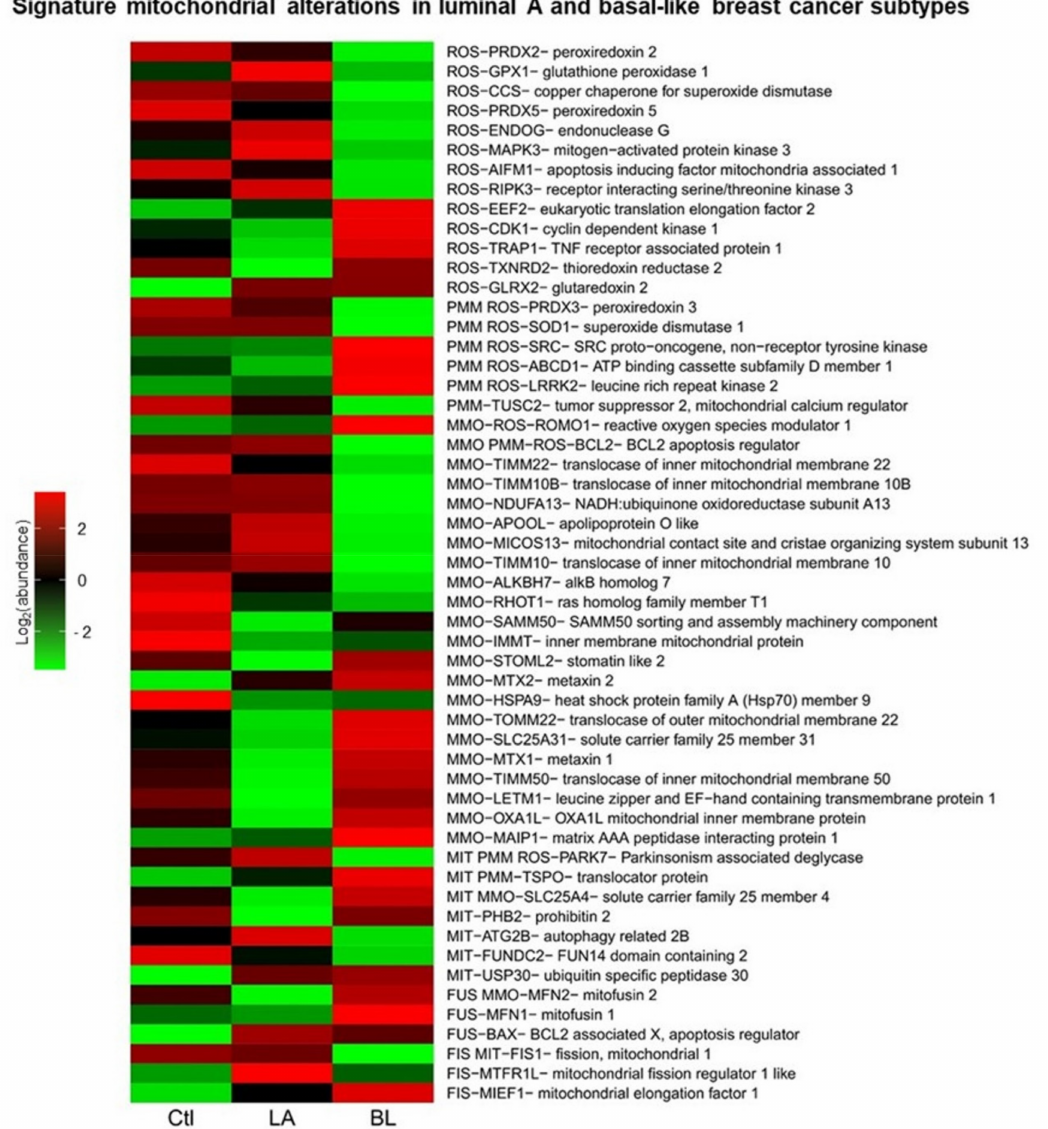
Figure 9. Signature mitochondrial alterations in luminal type A and basal-like breast cancer. Ex- pression profiles of proteins involved in regulation and formation of reactive oxygen species (ROS), mitochondrial membrane potential (MMP), mitochondrial membrane organization (MMO), mi- tophagy (MIT), mitochondrial fusion (FUS) and mitochondrial fission (FIS), in control samples, luminal A and basal-like breast cancer